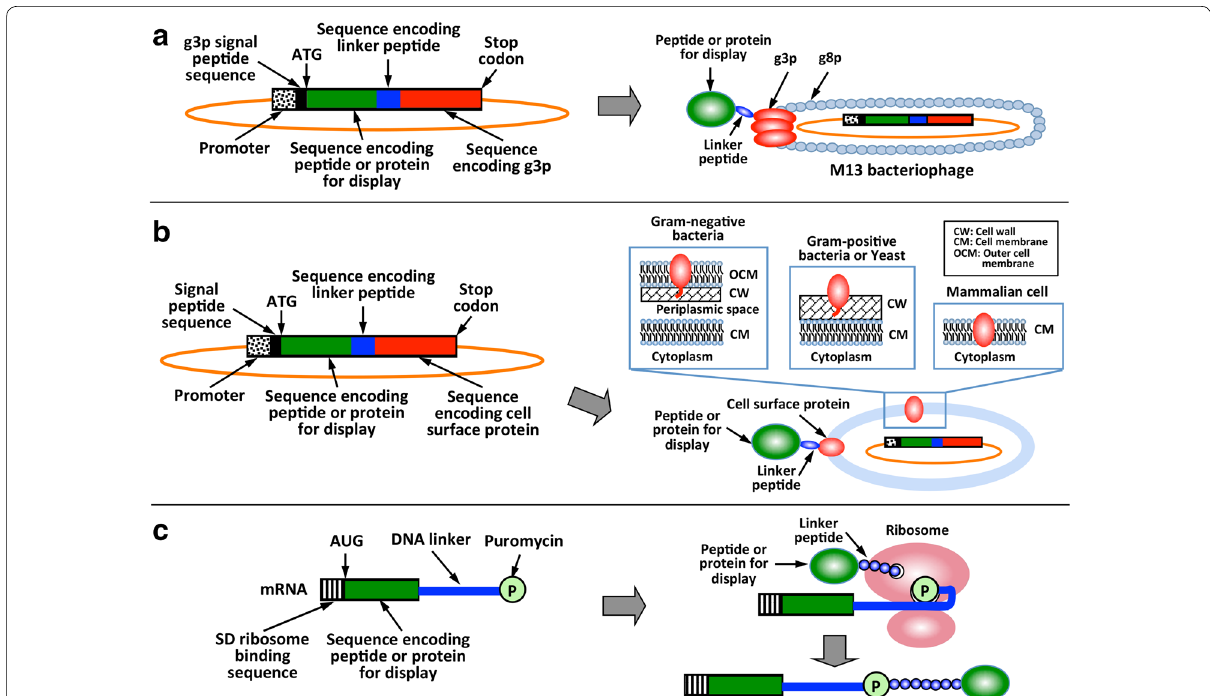
Fig. 18 Various genotype–phenotype linkage technologies. a Phage display technology. b Cell surface display technologies: in vivo display on the surface of bacteria, yeast or mammalian cell. c RNA display